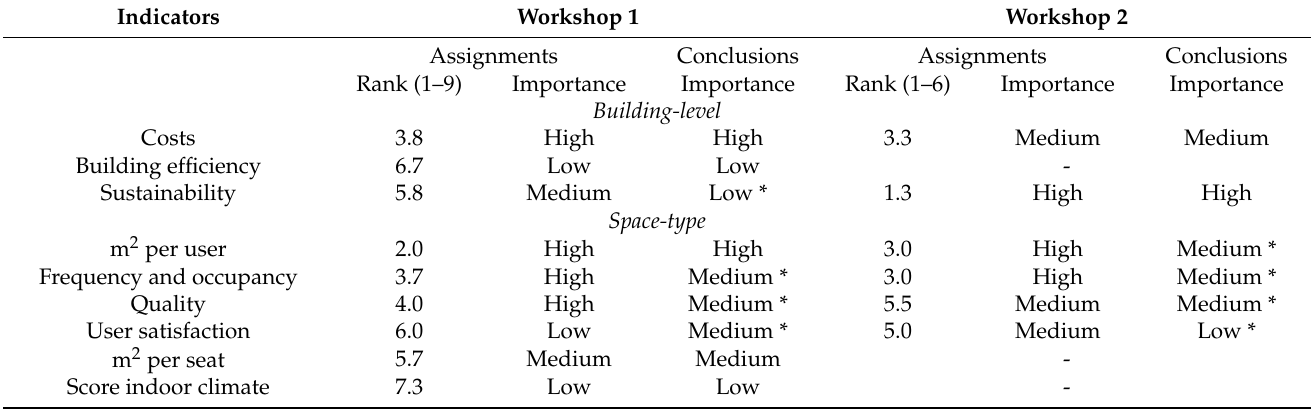
Table 6. Use of the indicators during the assignments and in forming conclusions (case TUD). Asterisks (*) denote instances in which the importance based on the conclusions deviates from the importance based on the